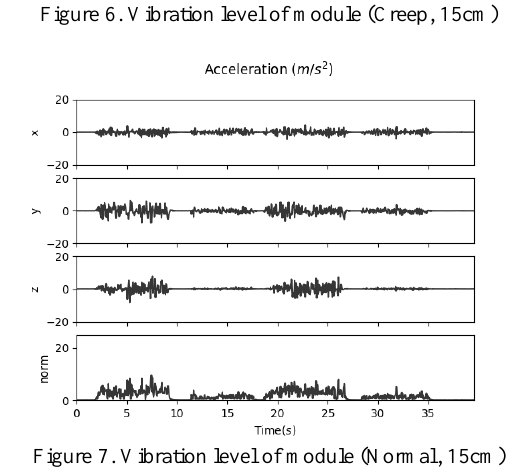
Figure 10. Vibration level of module (Creep, 50cm)